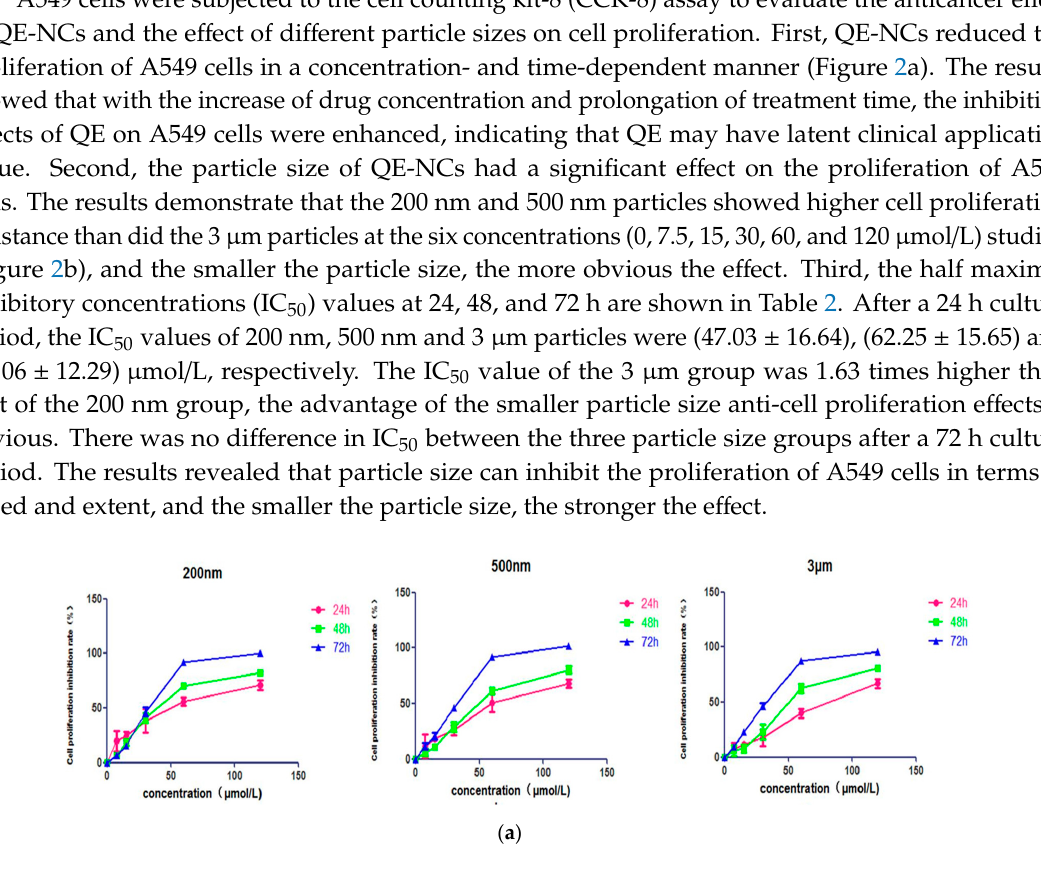
Figure 1. Characterization of QE-NCs with different sizes from transmission electron microscopy (TEM) observation.